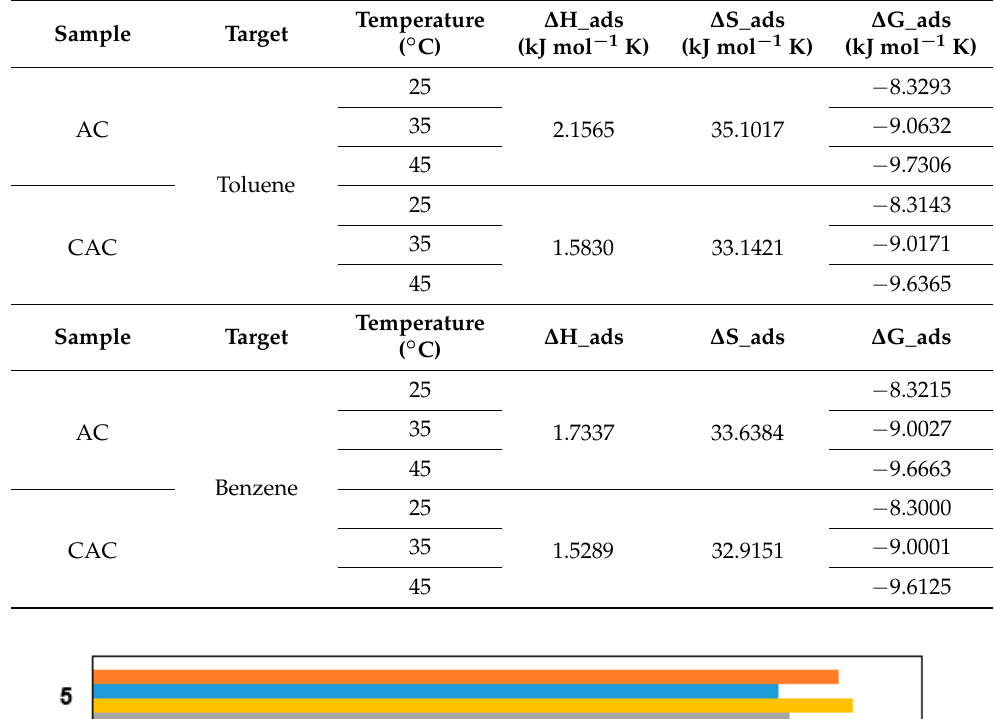
Table 6. Thermodynamic parameters for VOCs adsorption on the samples by various temperature ranges.